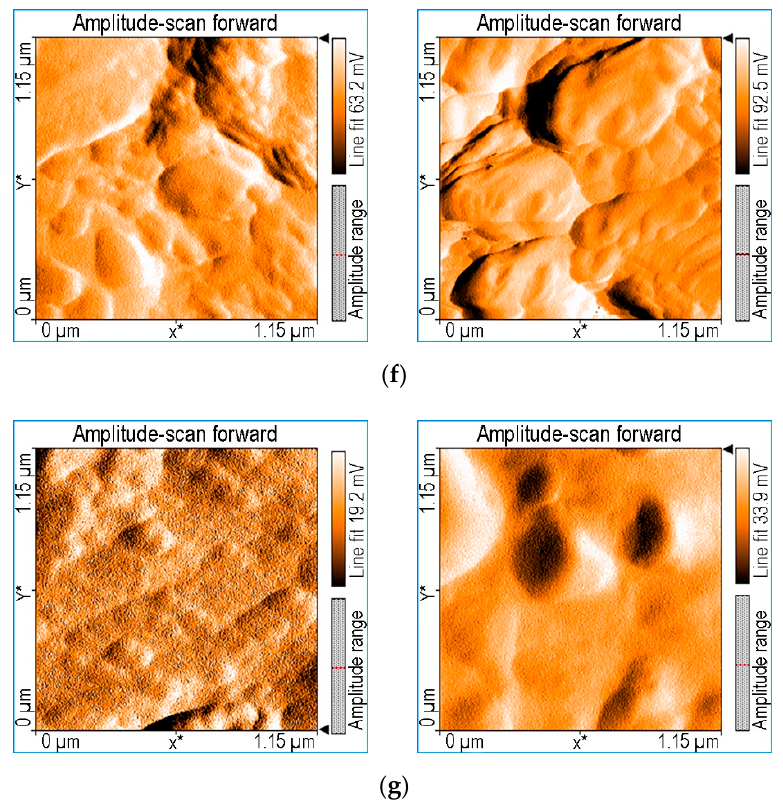
Figure 2. 2D AFM images for the covering layers, before and after corrosion tests: bare OL electrode; ( a ) MnTa 2 O 6 ; ( b ) 5,10-(4-carboxy-phenyl)-15,20-(4-phenoxy-phenyl)-porphyrin; ( c ) 5,15-(4-carboxy- phenyl)-10,20-bis-phenylporphyrin; ( d ) MnTa 2 O 6 /5,10-(4-carboxy-phenyl)-15,20-(4-phenoxy-phenyl)- porphyrin; ( e ) 5,10-(4-carboxy-phenyl)-15,20-(4-phenoxy-phenyl)-porphyrin/MnTa 2 O 6 ; ( f ) MnTa 2 O 6 / 5,15-(4-carboxy-phenyl)-10,20-bis-phenylporphyrin; ( g ) 5,15-(4-carboxy-phenyl)-10,20-bis-phenylpor-